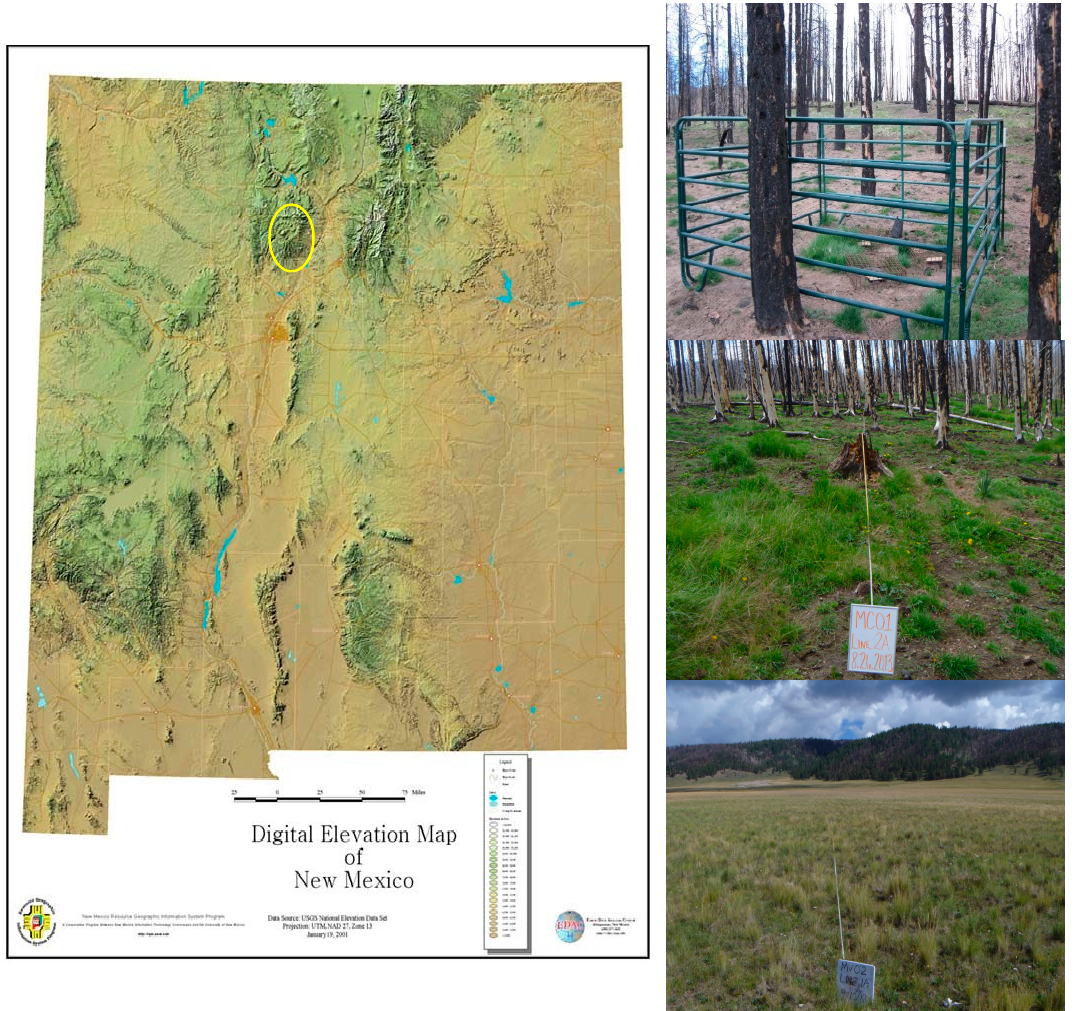
Figure 1. Map of New Mexico. Yellow oval outlines the Valles Caldera National Preserve. The three habitats affected by the Las Conchas fire: Ponderosa pine forest, top; Mixed-conifer forest, middle; Mountain Valley Grassland, bottom. The ponderosa pine image shows the pitfall and fencing arrangement.